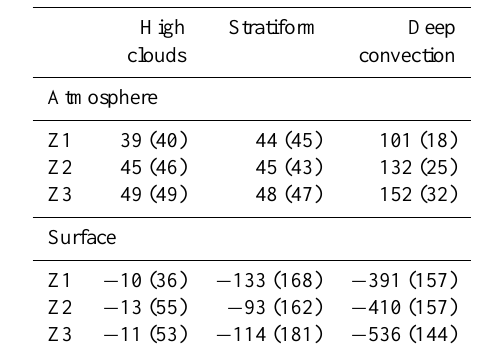
Table 1. Area-averaged (northwards of the Equator) cloud radia- tive effect (CRE) and its standard deviation (in brackets) of three selected cloud types. The months of JJAS are selected for analysis. All values are in Wm − 2 .